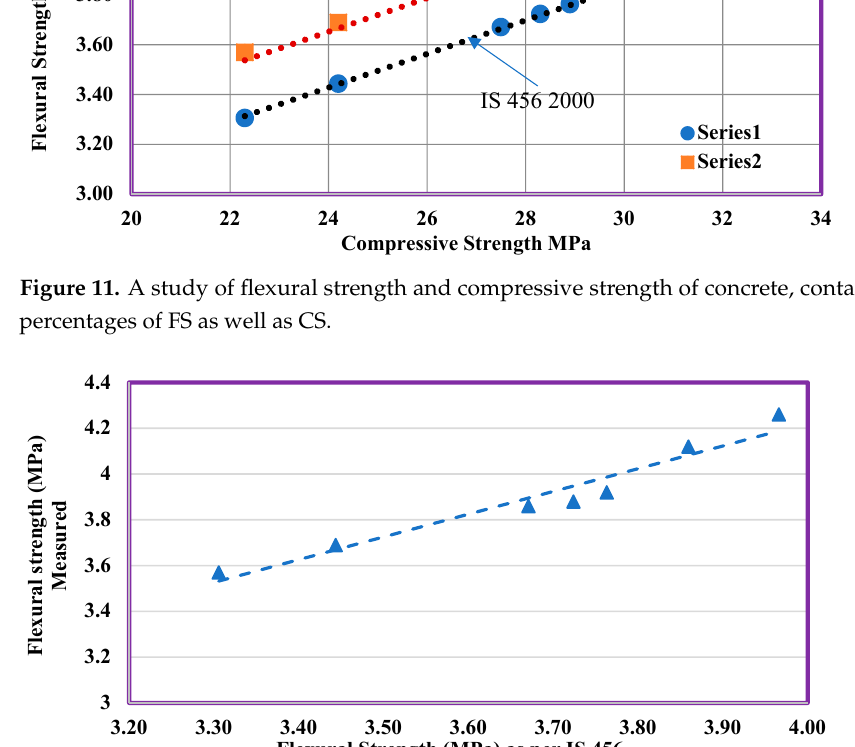
Table 9. Comparison of experimental and predicted values of flexural strength.